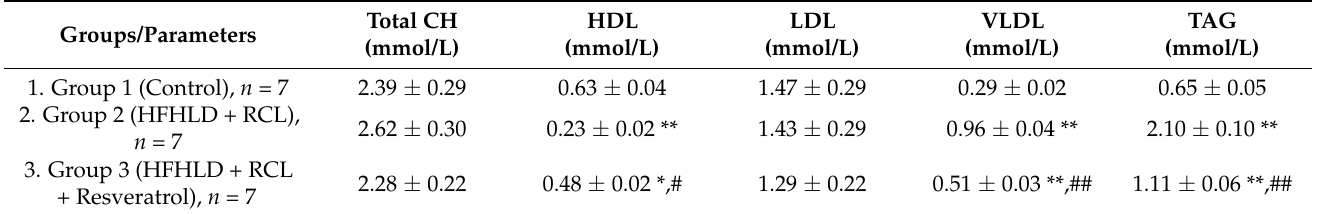
Table 5. Effects of resveratrol on lipid profile in the serum of rats fed a high-fructose high-lipid diet (HFHLD) under round-the-clock lighting